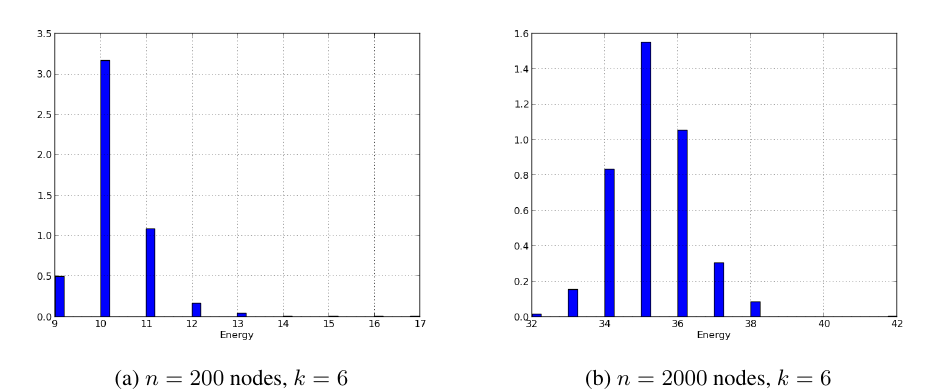
Fig. 3: Different aaverage latency dependently on the size of the